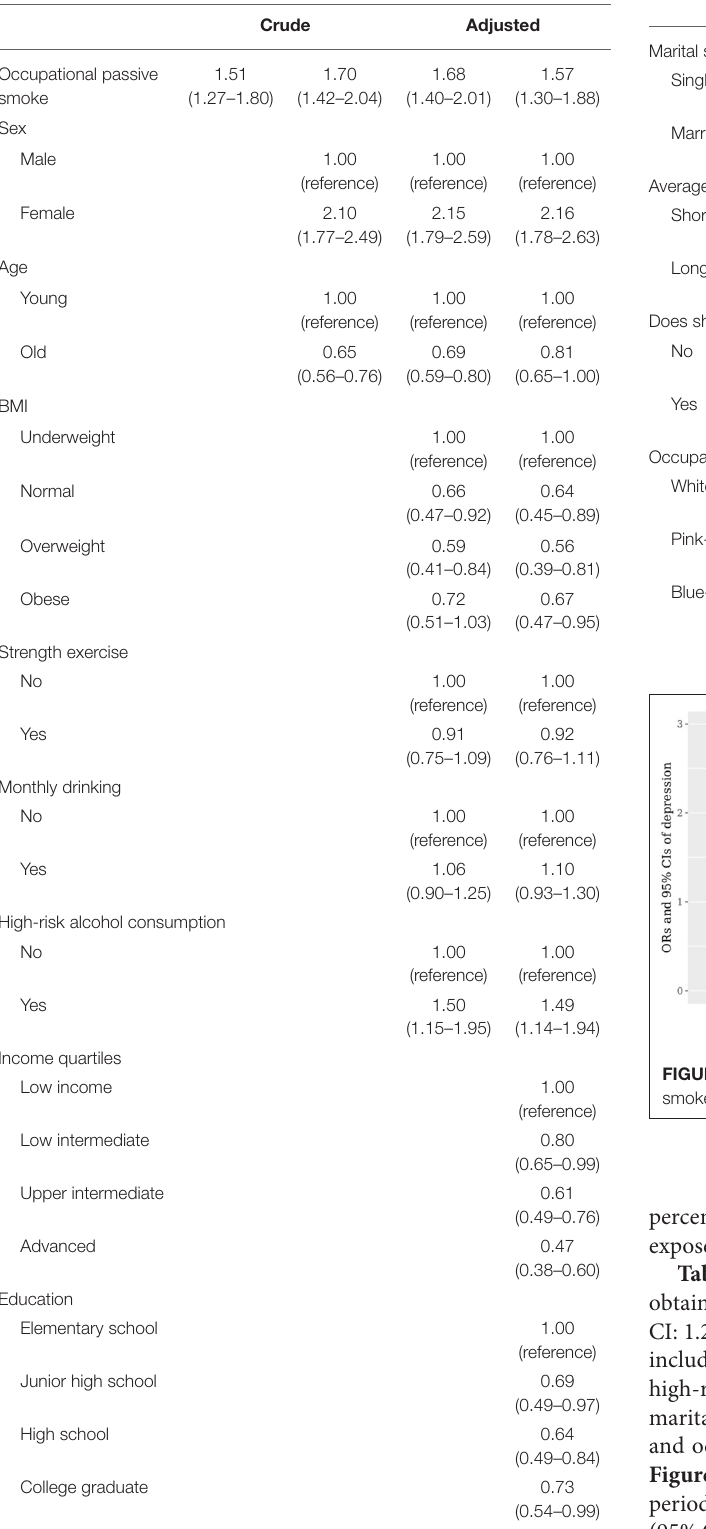
TABLE 2 | Odds ratios of occupational secondhand smoke and depression (adjusted and not adjusted).